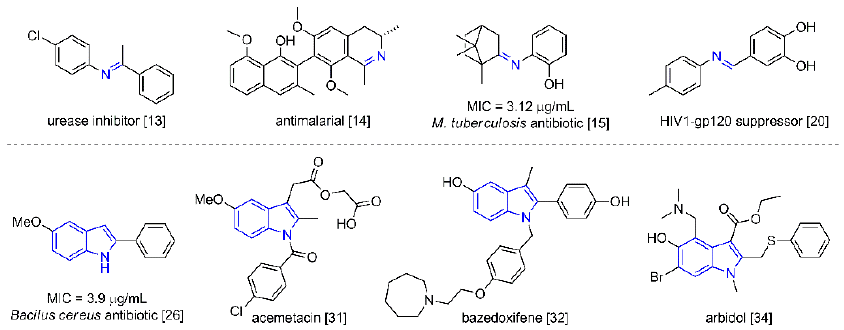
Figure 1. Imine- and indole-containing compounds with pharmacological activity.